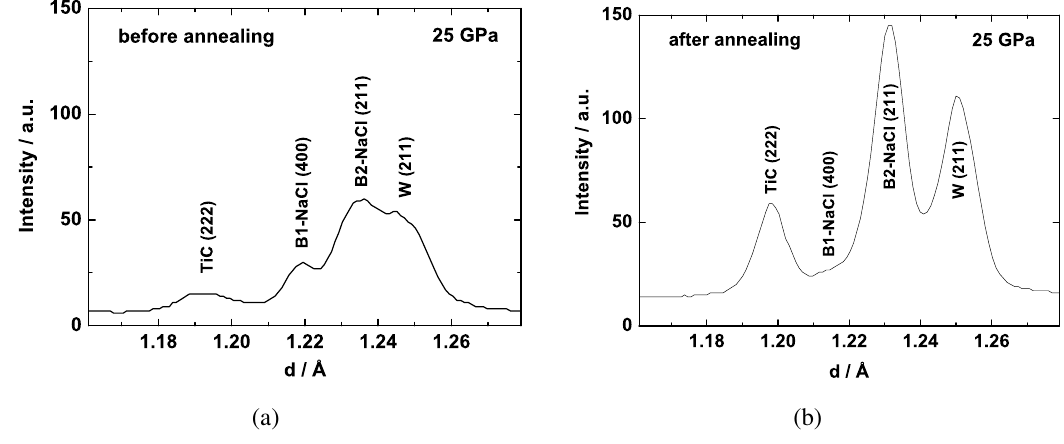
Laser-heating a mixture of Ti and graphite, thermally insulated by NaCl,